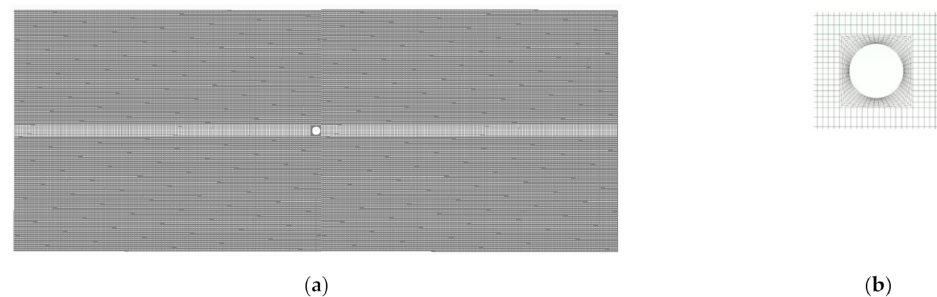
Figure 2. ( a ) Discretized model for the single cylinder, ( b ) a closer view of the grid for the single cylin- der.